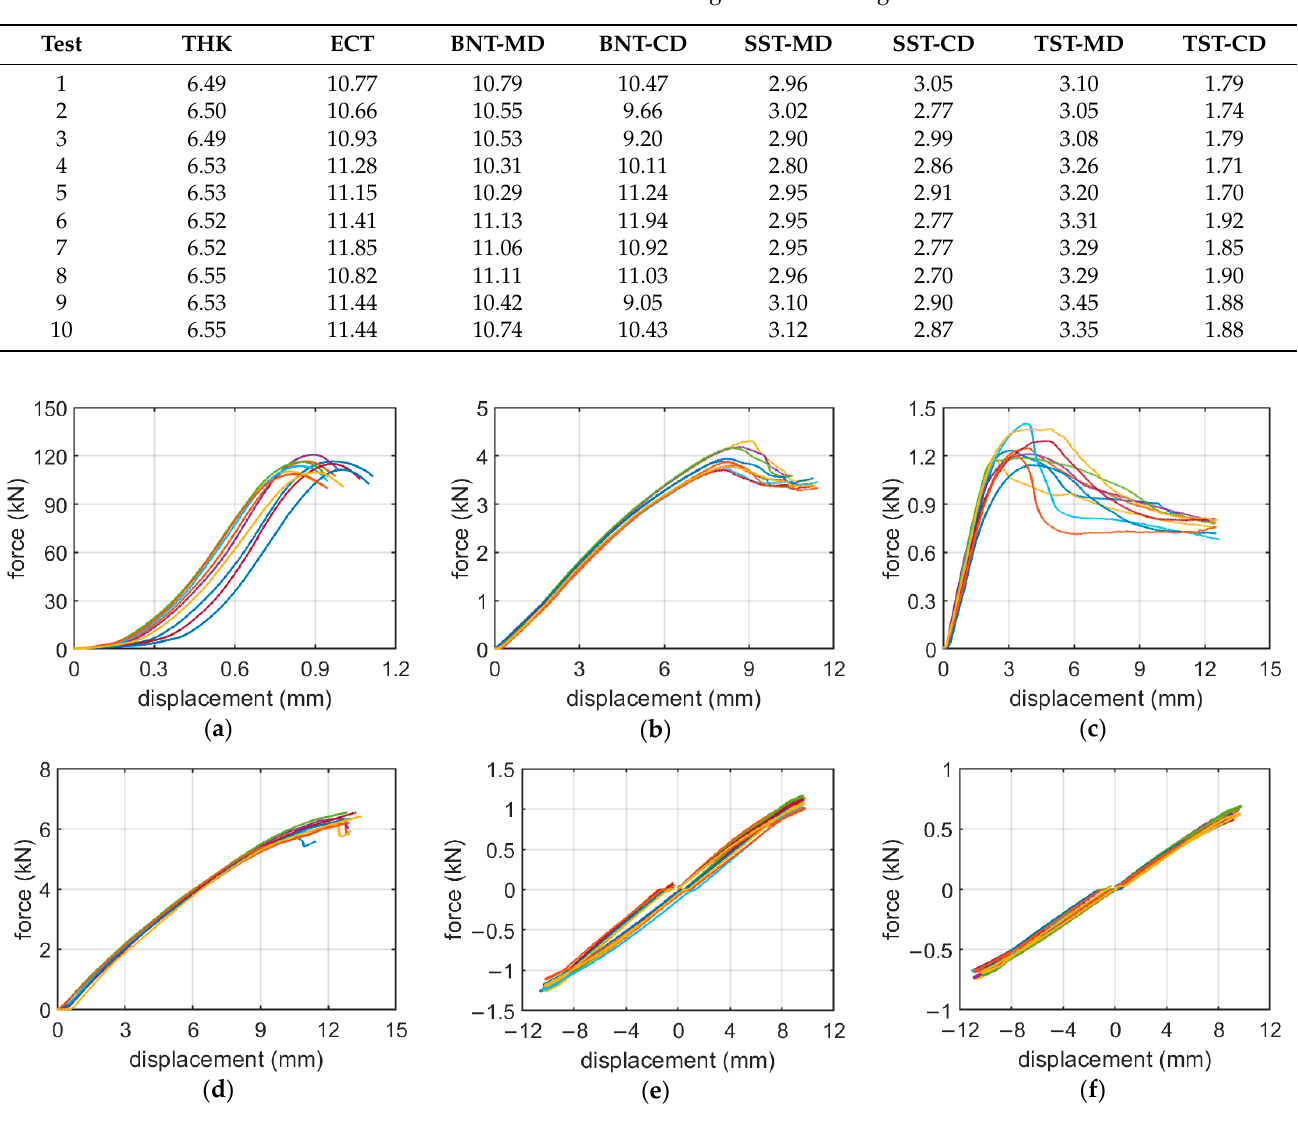
Figure 9. Force-displacement curves for BC-780 corrugated cardboard in various tests: ( a ) ECT; ( b ) BNT–MD; ( c ) BNT–CD; ( d ) SST; ( e ) TST–MD; ( f ) TST–CD. Table 2. Test values for corrugated cardboard